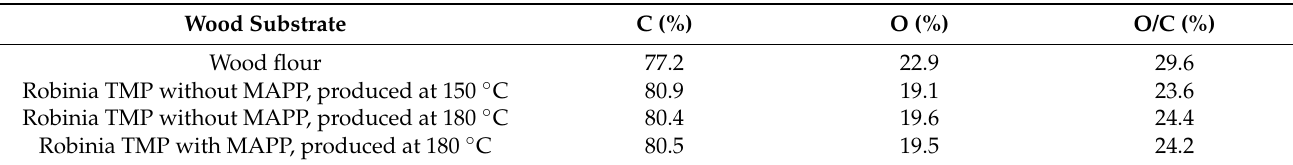
Table 2. Elemental composition and oxygen-carbon ratio of Robinia TMP and commercial softwood flour as obtained by XPS survey spectra.